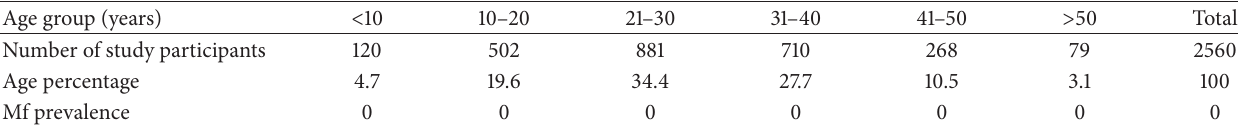
Figure 1: Zonal map of Ethiopia with water lines and study areas (Bale, Borena, and W. Arsi zones). Table 1: Age category of study participants and microfilariae prevalence